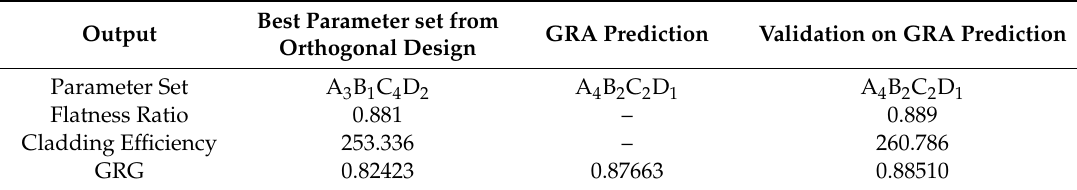
Table 10. Optimization and experimental validation result